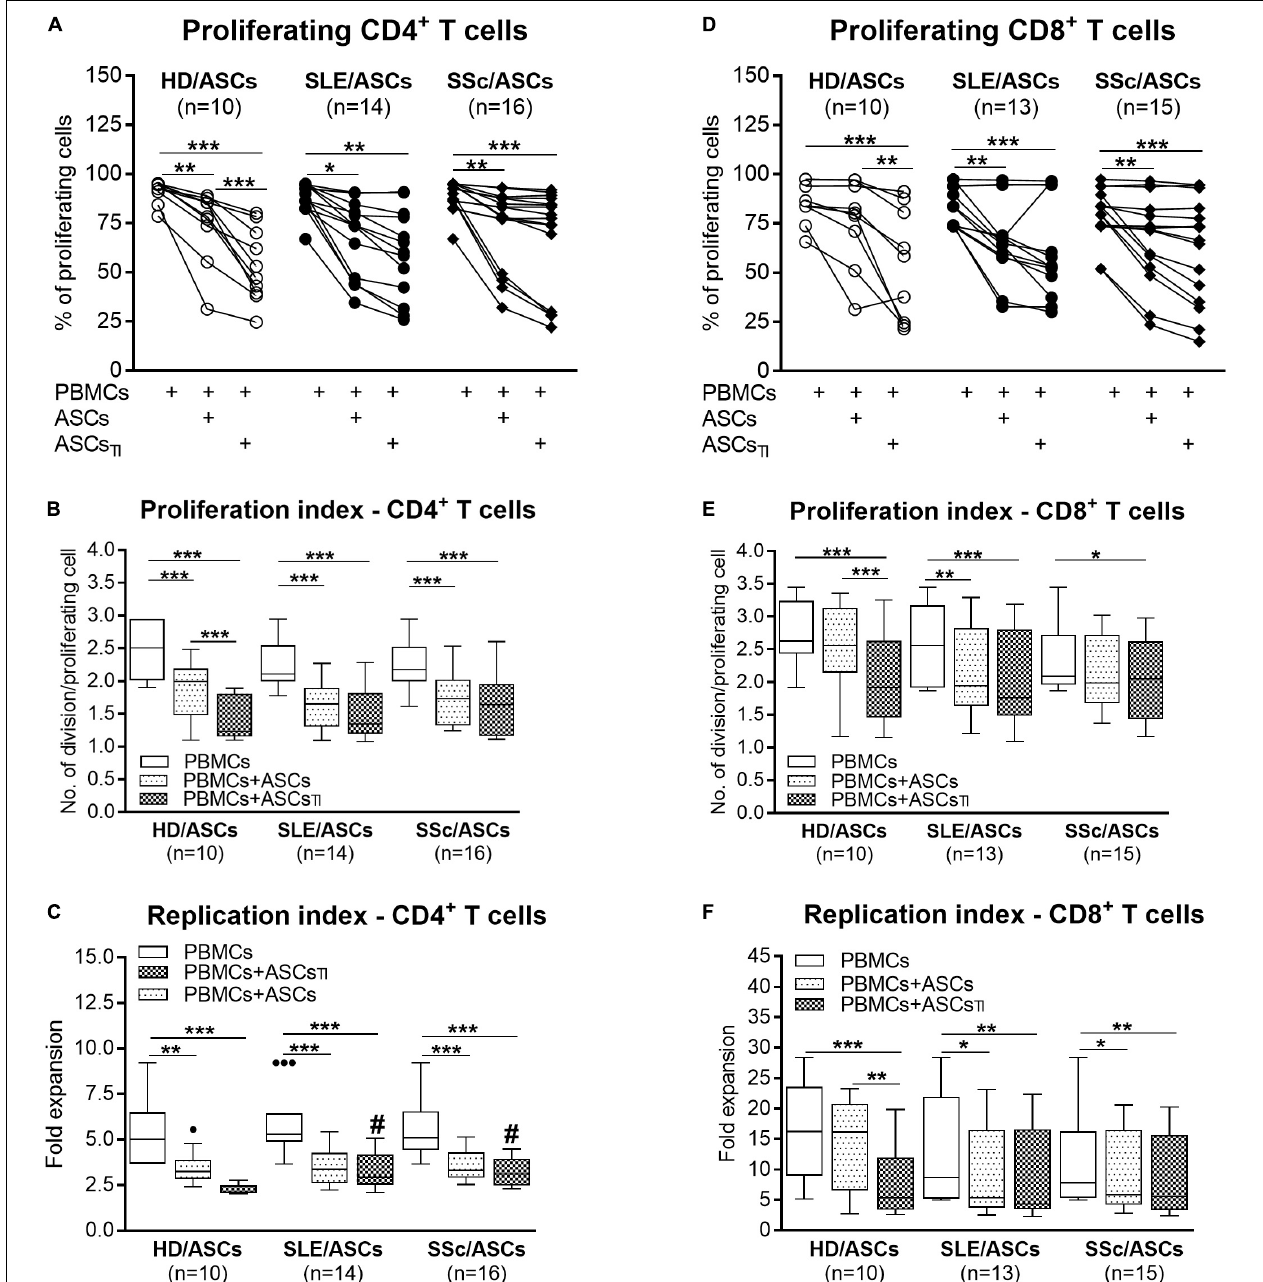
FIGURE 1 | Inhibition of proliferation of CD4 + and CD8 + T cells by ASCs of healthy donors, SLE, and SSc patients in the co-cultures with peripheral blood mononuclear cells (PBMCs). PBMCs obtained from 9 healthy blood volunteers were stimulated with PHA and cultured alone (PBMCs) or co-cultured for 5 days with untreated (ASCs) or cytokine-licensed (ASCs TI ) ASCs from 5 healthy donors (HD/ASCs), 9 SLE (SLE/ASCs), and 10 SSc (SSc/ASCs) patients. The proliferation of CD4 + (A–C) and CD8 + (D–F) T cells was analyzed by flow cytometry. (A,D) Lines between points identify the same combination of co-cultured ASCs and PBMCs. (B–F) Results of the indicated number of experiments ( n ), expressed as the median (horizontal line) with interquartile range (IQR, box), lower and upper whiskers (data within 3/2 × IQR), and outliers (points) (Tukey’s box). * P < 0.05, ** P < 0.01, *** P < 0.001 for intra-group comparisons; # P < 0.05 for the groups of patients versus HD